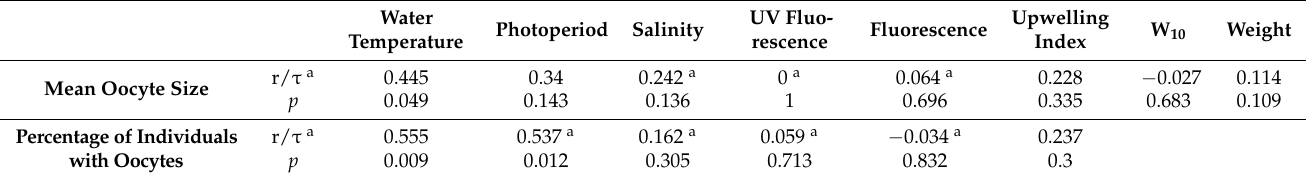
a Kendall rank correlation tests were used in these variables. p value (P) is also